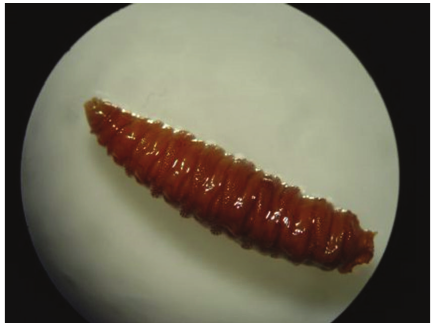
Figure 5: Photomicrograph showing a solitary larva of Chrysomya bezziana with tapered body and characteristic transverse grooves.